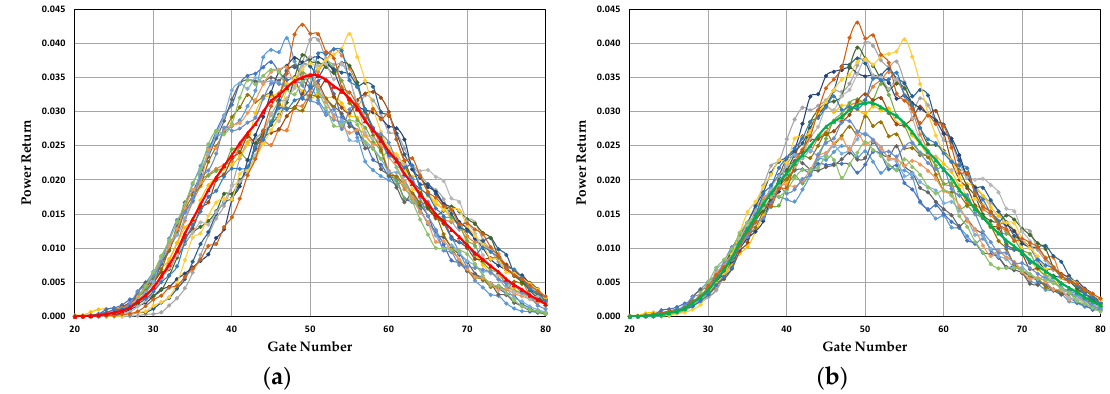
Figure 8. Simulated waveforms on a 20 Hz sample for sinusoidal wave train (wave height H = 4 m, T = 16 s) superimposed to a JONSWAP sea (significant wave height Hs = 4 m; peak period Tp = 8 s): ( a ) without R-effect (red curve represents the average value); ( b ) with R-effect (green curve represents the average value).